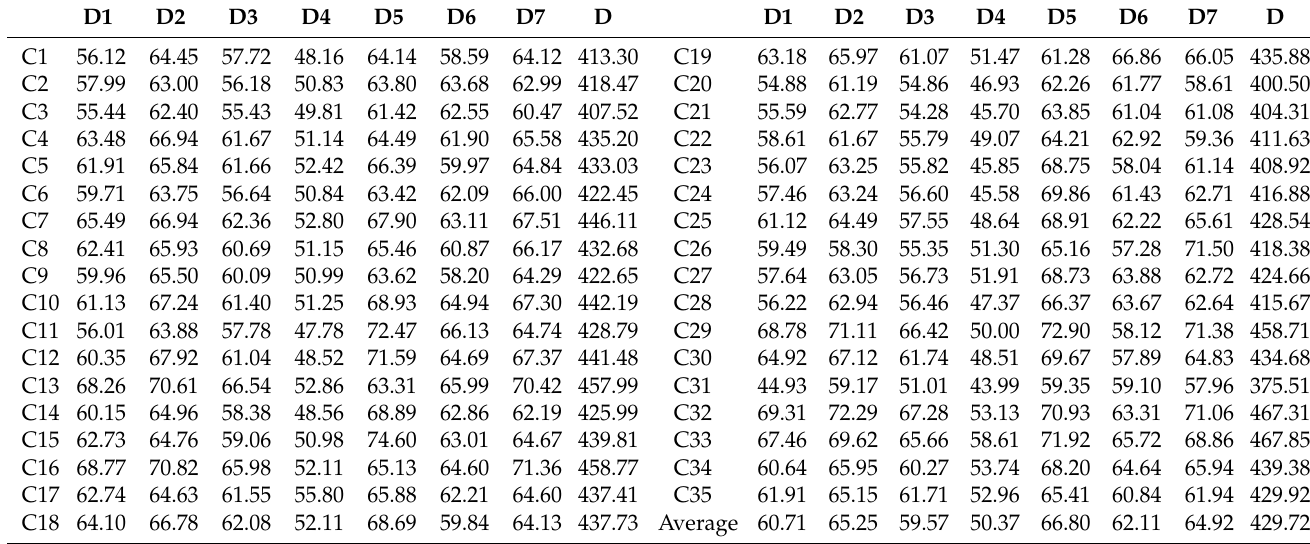
Table 5. The value of qualitative UPSCC performance value for the sample cities.